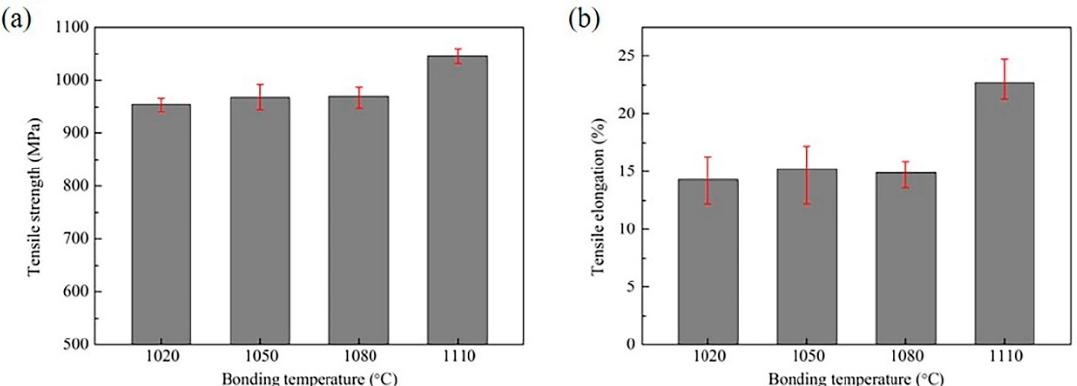
Figure 7. Tensile test results of the joints diffusion-bonded at different temperatures: ( a ) tensile strength and ( b ) elongation.